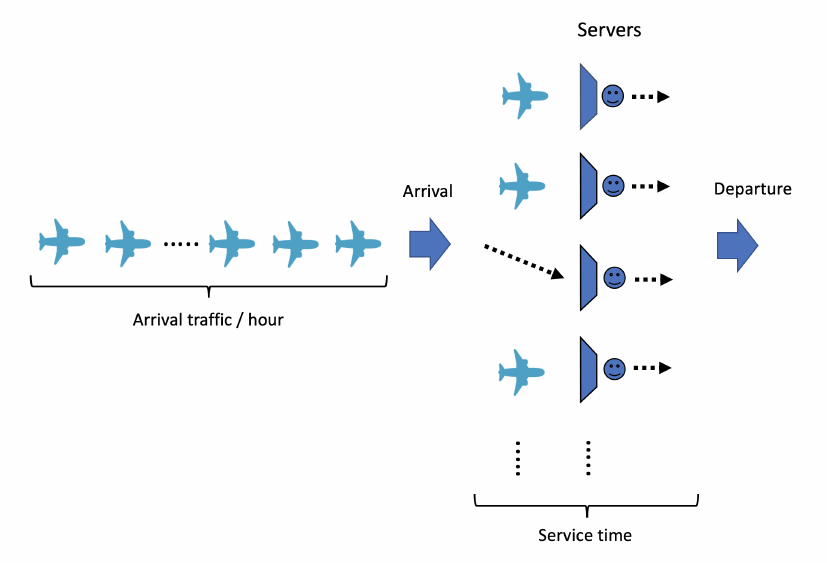
Figure 6. Example of a queuing model for aircraft arrival